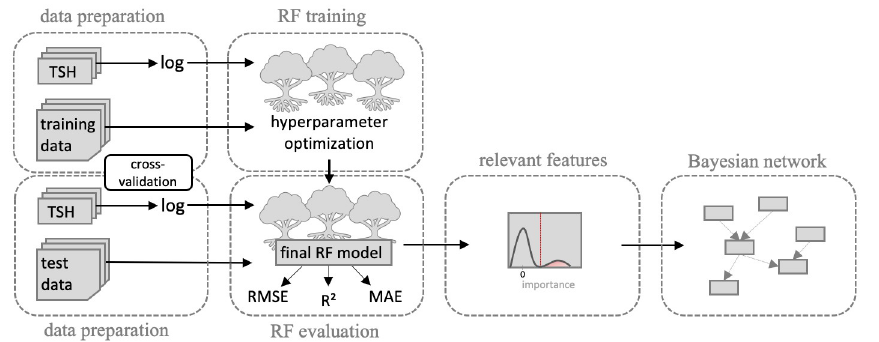
Fig 1. Workflow. Schematic representation of the workflow. After data preparation, a RF model is trained using nested cross-validation. Relevant predictors are identified based on two feature importance measures and a mixture model approach. Lastly, feature interactions among the relevant predictors are examined in a Bayesian network